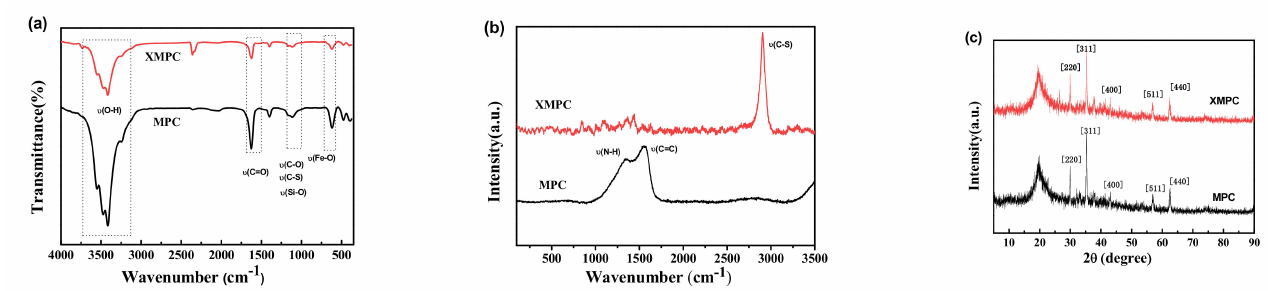
Figure 1. ( a ) FTIR spectra, ( b ) Raman spectra, and ( c ) XRD patterns of the XMPC and MPC. The thermal characteristics of the XMPC were determined by its thermogravimetric analysis (TG) and differential scanning calorimeter (DSC) curves, and the results are shown in Figure 2a,b. In the TG and DTG curves, slight weight loss occurred below 150 ◦ C, corresponding to the evaporation of absorbed and linked water in the material. The most significant weight loss occurred between 150 ◦ C and 450 ◦ C as a result of the structural degradation of CS and PVA. The final weight loss between 450 ◦ C and 750 ◦ C was attributed to charring due to the temperature exceeding the maximum degradation temperature of the material [52]. In the DSC curve, shown in Figure 2b, an exothermic peak was observed at approximately 101.2 ◦ C, which may be due to the release of bound water in the XMPC. This was supported by the results of TGA. The glass transition temperatures (Tg) of PVA and CS were not found in the DSC curve, which also indicated that the new material, the XMPC, was formed successfully.